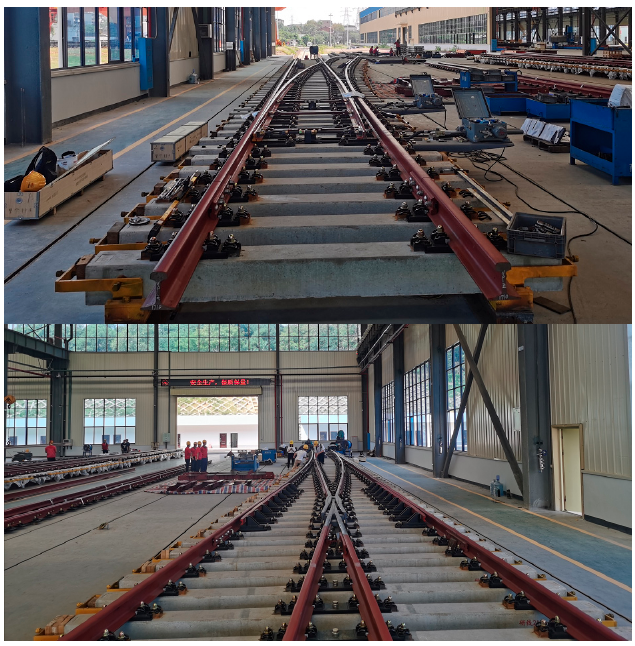
Figure 9. Laying of new No. 9 single turnout of 60-kg/m rail on manufacturing site.